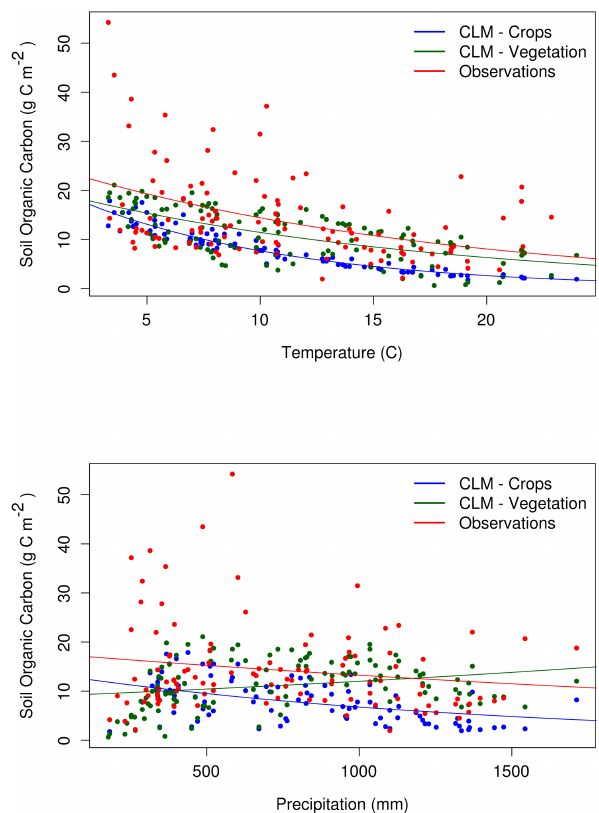
Figure 4. The effects of temperature (top) and precipitation (bot- tom) on SOC stock from CLM crops (blue), natural vegetation (green) and ISCN observations (red).